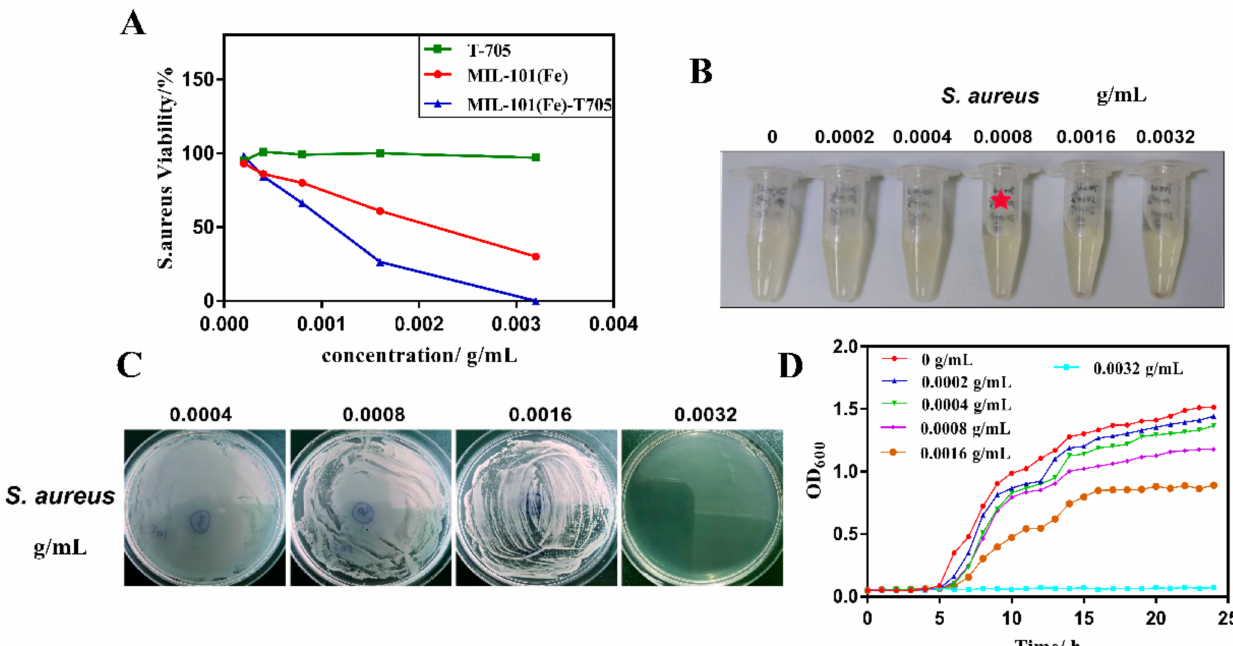
Figure 8. Antibacterial application in vitro. ( A ) Bacterial survival rate of S. aureus treated with different concentrations of T-705, MIL-101(Fe), and MIL-101(Fe)-T705. ( B ) Minimum inhibitory concentration of S. aureus after treatment with different concentrations of MIL-101(Fe)-T705. The red star means minimum inhibitory concentration of S. aureus. ( C ) Minimum bactericidal concentration of S. aureus after treatment with different concentrations of MIL-101(Fe)-T705. ( D ) Twenty-four-hour growth curves of S. aureus treated with different concentrations